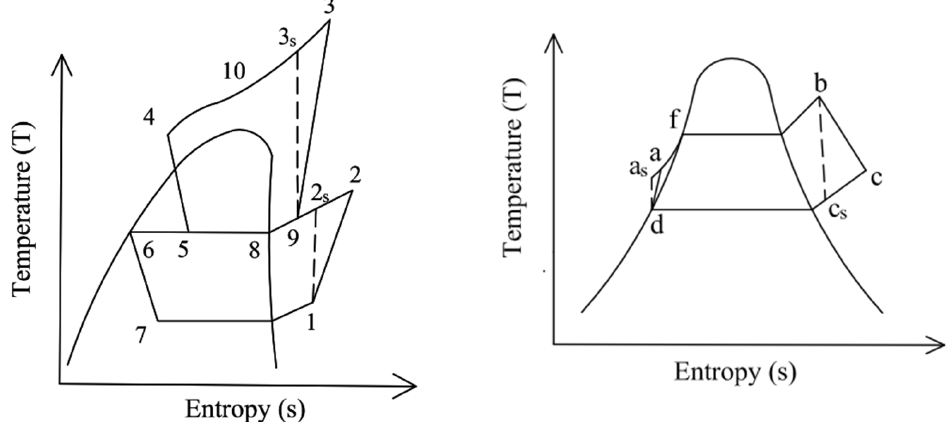
Figure 2. T–S diagram of the CO 2 transcritical two stage compression refrigeration system based on an ORC system.